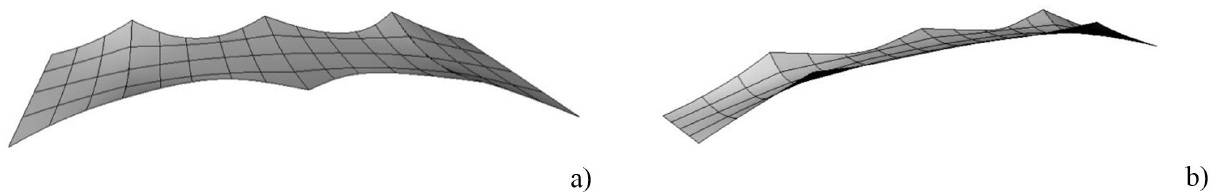
Figure 4: Form-finding of the shell-supported footbridge using simulated annealing: (a) with isotropic curvatures; (b) after reduction of transverse curvatures